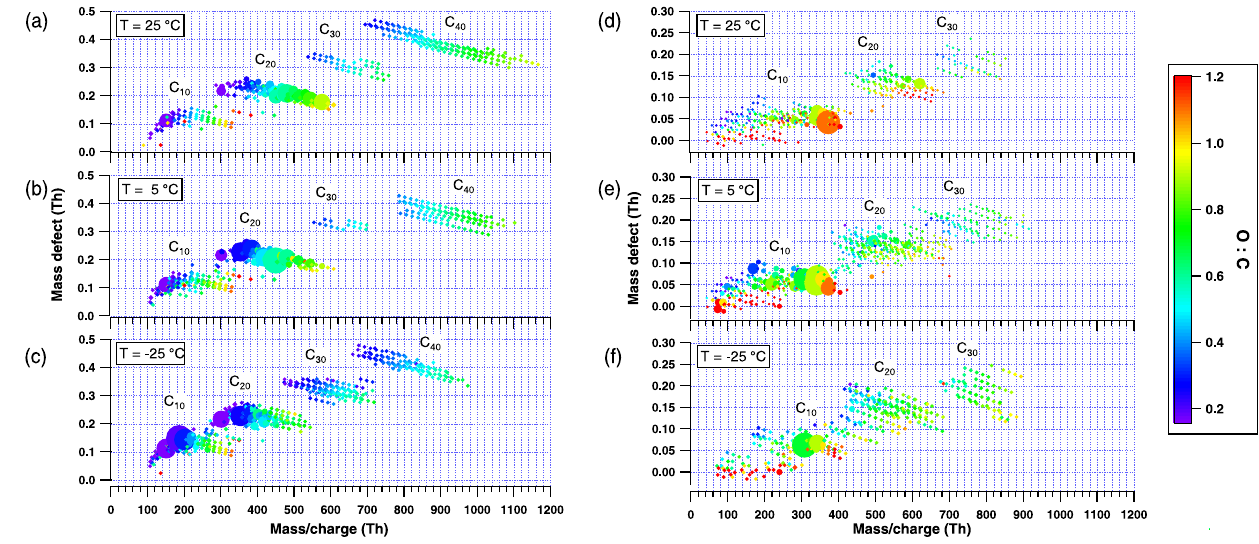
Figure 4. Mass defect plots with the color code denoting the O:C ratio (of the organic core) at 25, 5 and − 25 ◦ C for positive (a–c) and negative ion mode (d–f) . A lower O:C ratio is observed in the positive ion mode than in the negative ion mode. The intensity of the main peaks (linearly proportional to the size of the dots) changes with temperature for both polarities due to a lower degree of oxygenation at lower temperature.